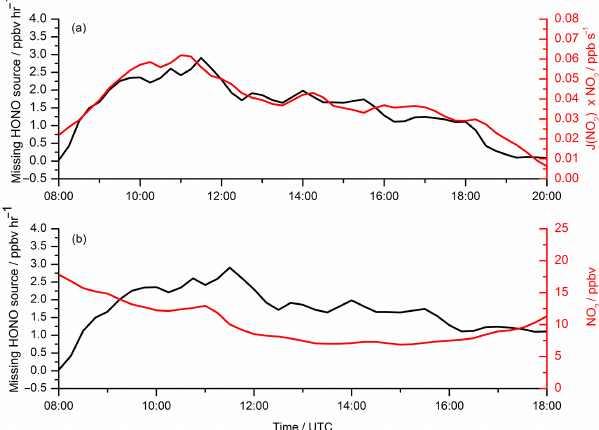
Figure 7. Average diurnal profiles of the missing HONO source (black traces) plotted with (as red traces) (a) NO 2 × j (NO 2 ) and (b) NO 2